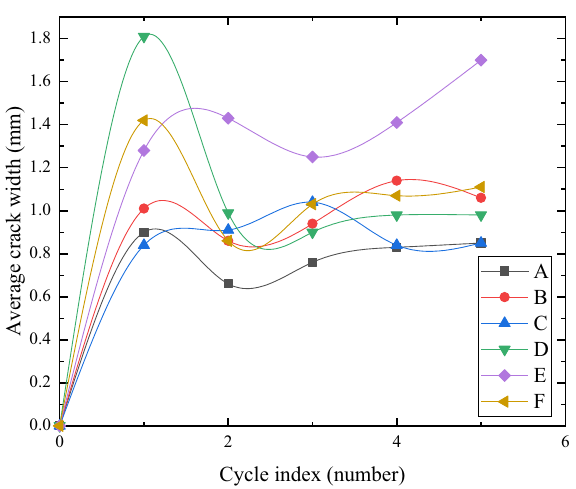
Figure 14. Development of average crack width in five dry–wet cycles ( a – e